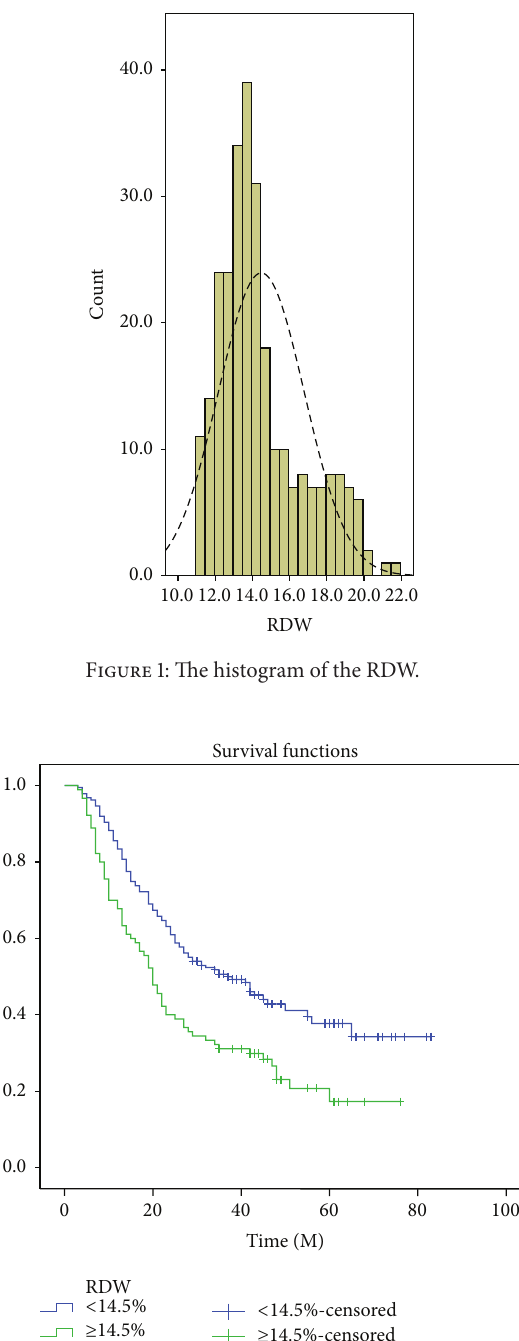
Figure 2: Kaplan-Meier CSS curves stratified by RDW. Patients with RDW < 14.5%hadasignificantlybetter5-yearCSSthanpatientswith RDW ≥ 14.5% (43.9% versus 23.3%, 𝑃 < 0.001 ).